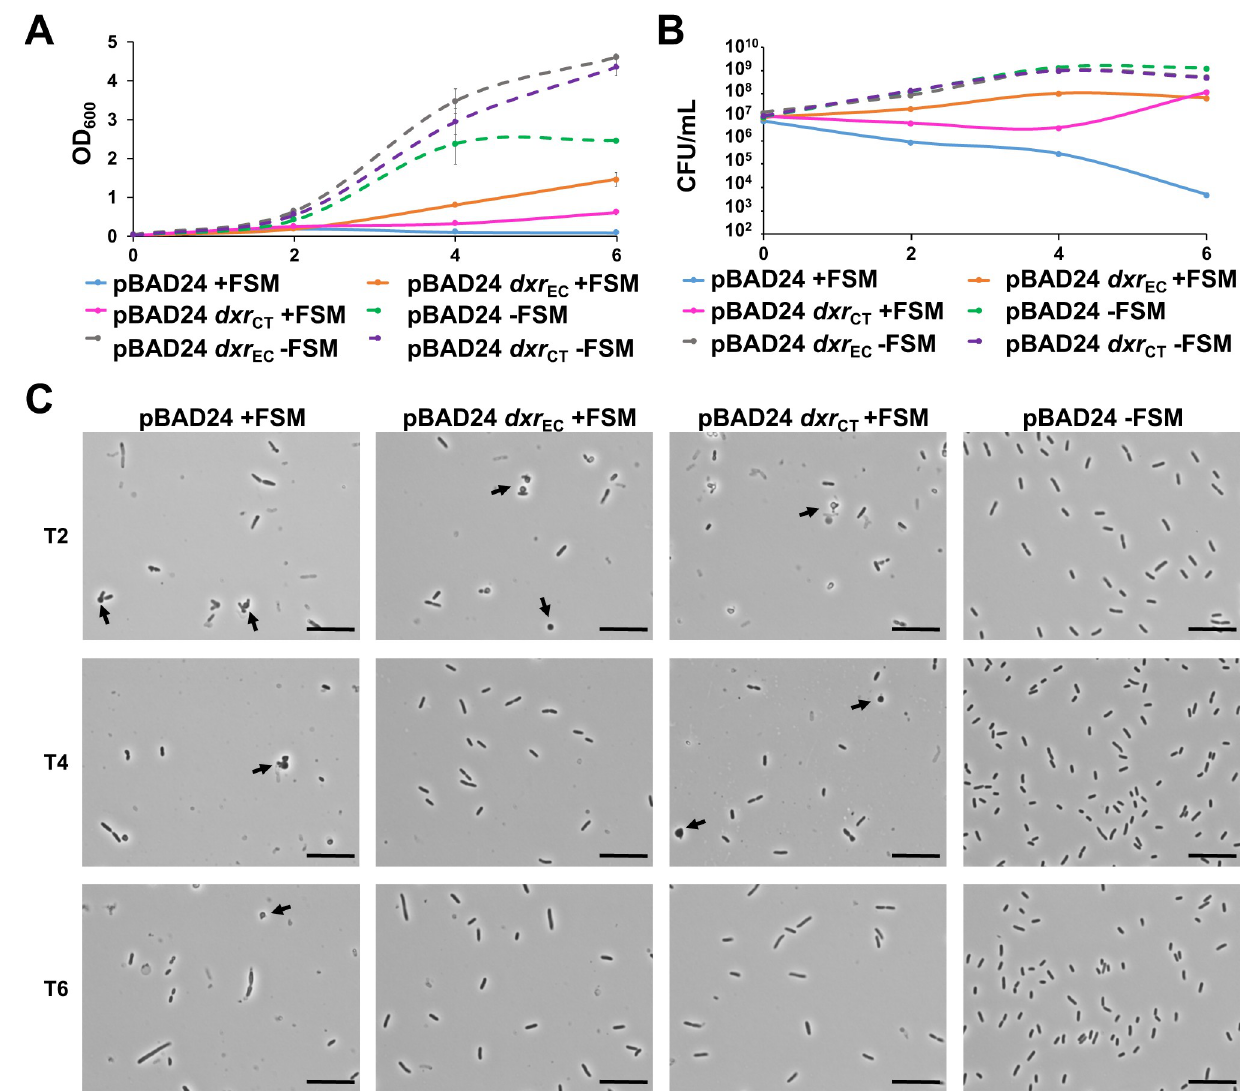
Fig 4. Overexpression of Dxr CT in E . coli supports growth and cellular morphology under FSM exposure. Overnight cultures of E . coli MG1655 carrying the indicated plasmids were subcultured 1:100 in LB broth + 0.2% arabinose either without FSM, or with 25 μ M FSM. OD 600 (A) and CFU (B) were determined every two hours for 6 hours. Phase contrast microscopy (C) was performed every two hours from T2 to T6. Arrows indicate rounded cell morphology observed during FSM exposure. Scale bars represent 10 μ m. OD 600 and microscopy data (A and C) are representative of three independent experiments, each performed with duplicate cultures. For CFU data (B) each curve depicts a single replicate that is representative of two independent experiments preformed in duplicate. Error bars in panel A represent the average of duplicate cultures from a single experiment +/- SD.